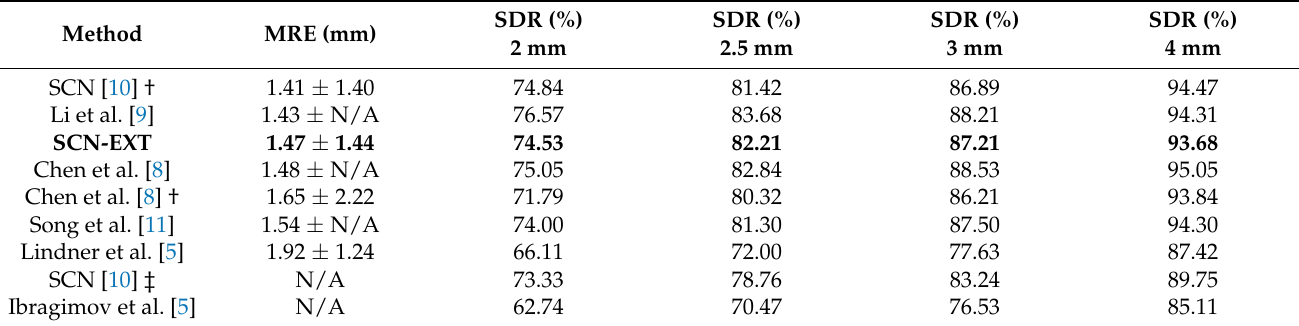
Table 5. Effectiveness of the cephalometric landmark detection methods on the public ISBI database: testing set 2. See Table 4 for